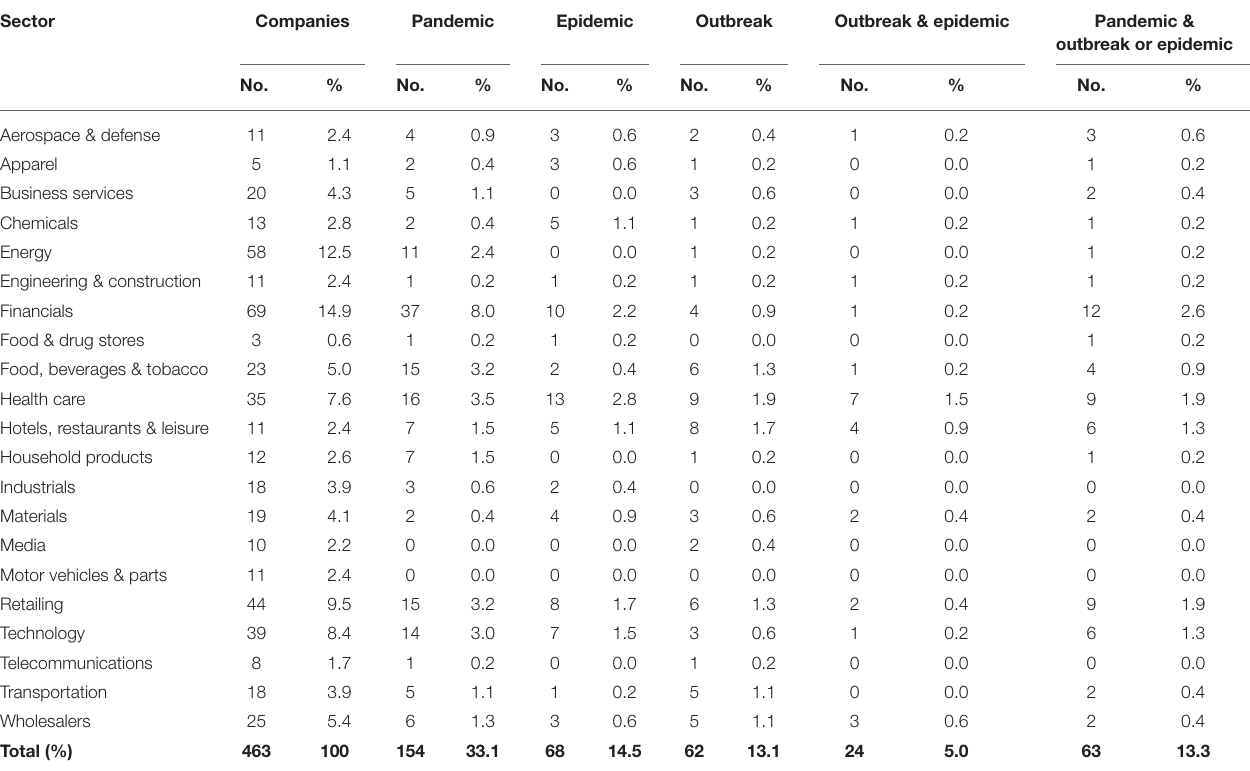
TABLE 1 | Distribution of the mention of key terms epidemic, pandemic, and outbreak in the risk factor section of 2018 Fortune 500 companies 10-K filings by sector.